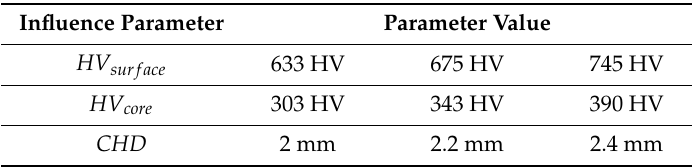
Table 3. Impact factor and